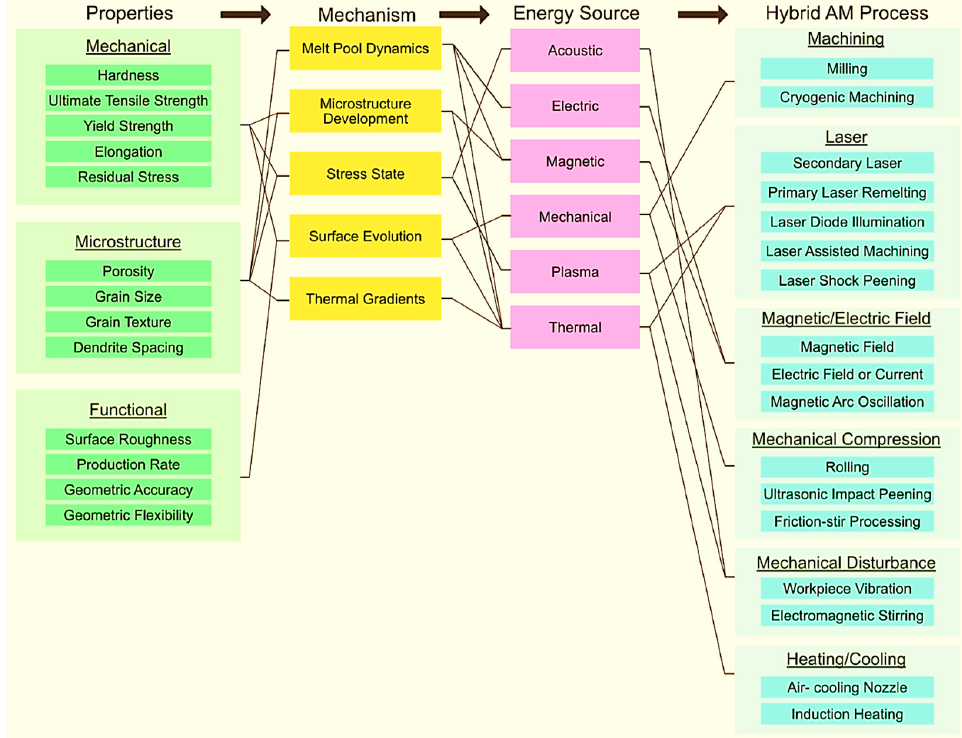
Figure 2. Property—mechanism—energy source—hybrid-AM process framework for hybrid-AM classified by mechanism and energy source utilization. Attending to the scheme, it is easy to understand why such a problem-oriented selection of the sample is possible [46].